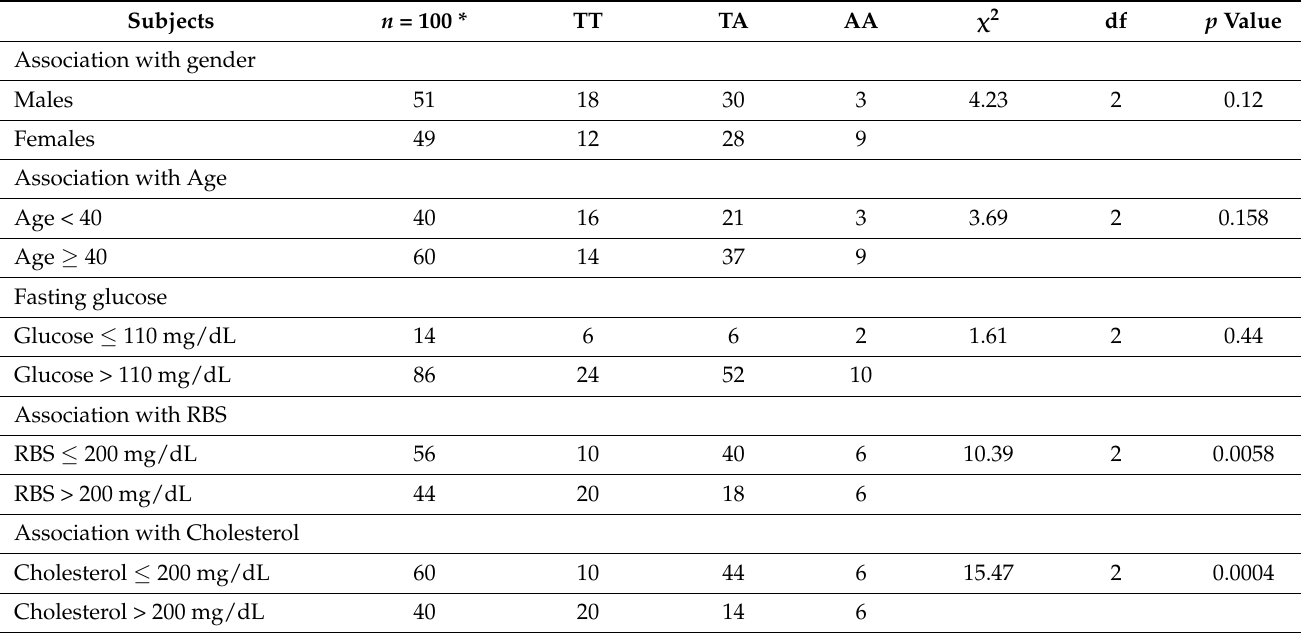
Table 6. Associations of GLO I-rs4647 A>C genotypes with patient